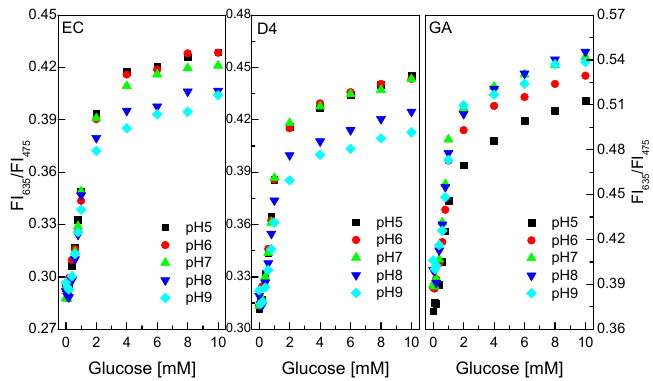
Figure 7. Response of GOD = PS@C6^PtP membranes with different supporting materials (EC, D4, and GA) at different glucose concentrations in pH range of